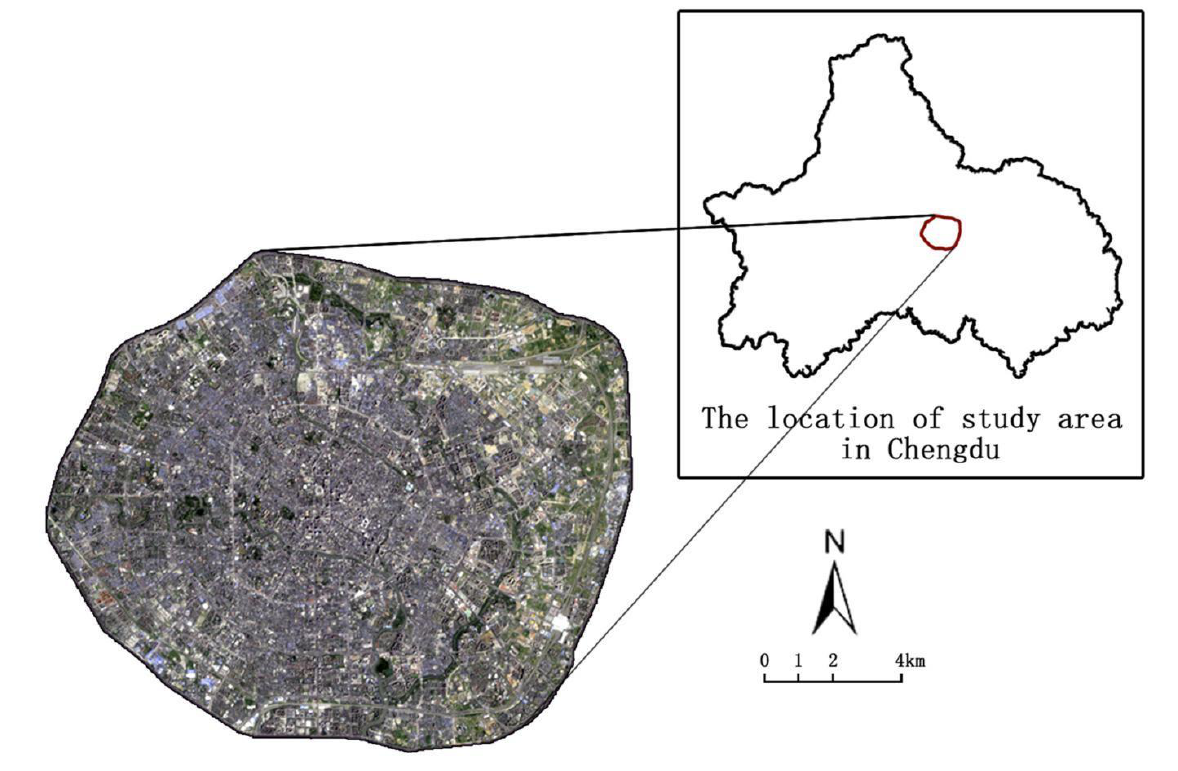
Figure 1. Satellite image of the study area